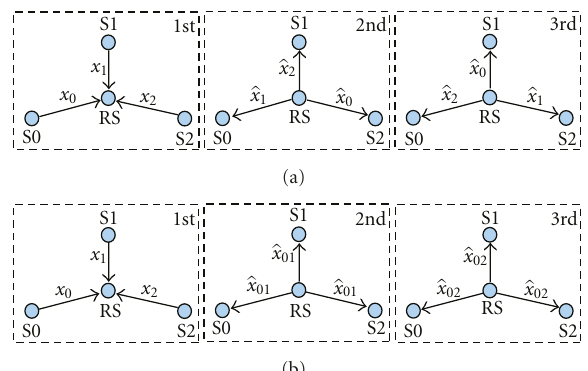
Figure 2: Multi-way relaying: (a) multiplexing transmission; (b) analog network coded